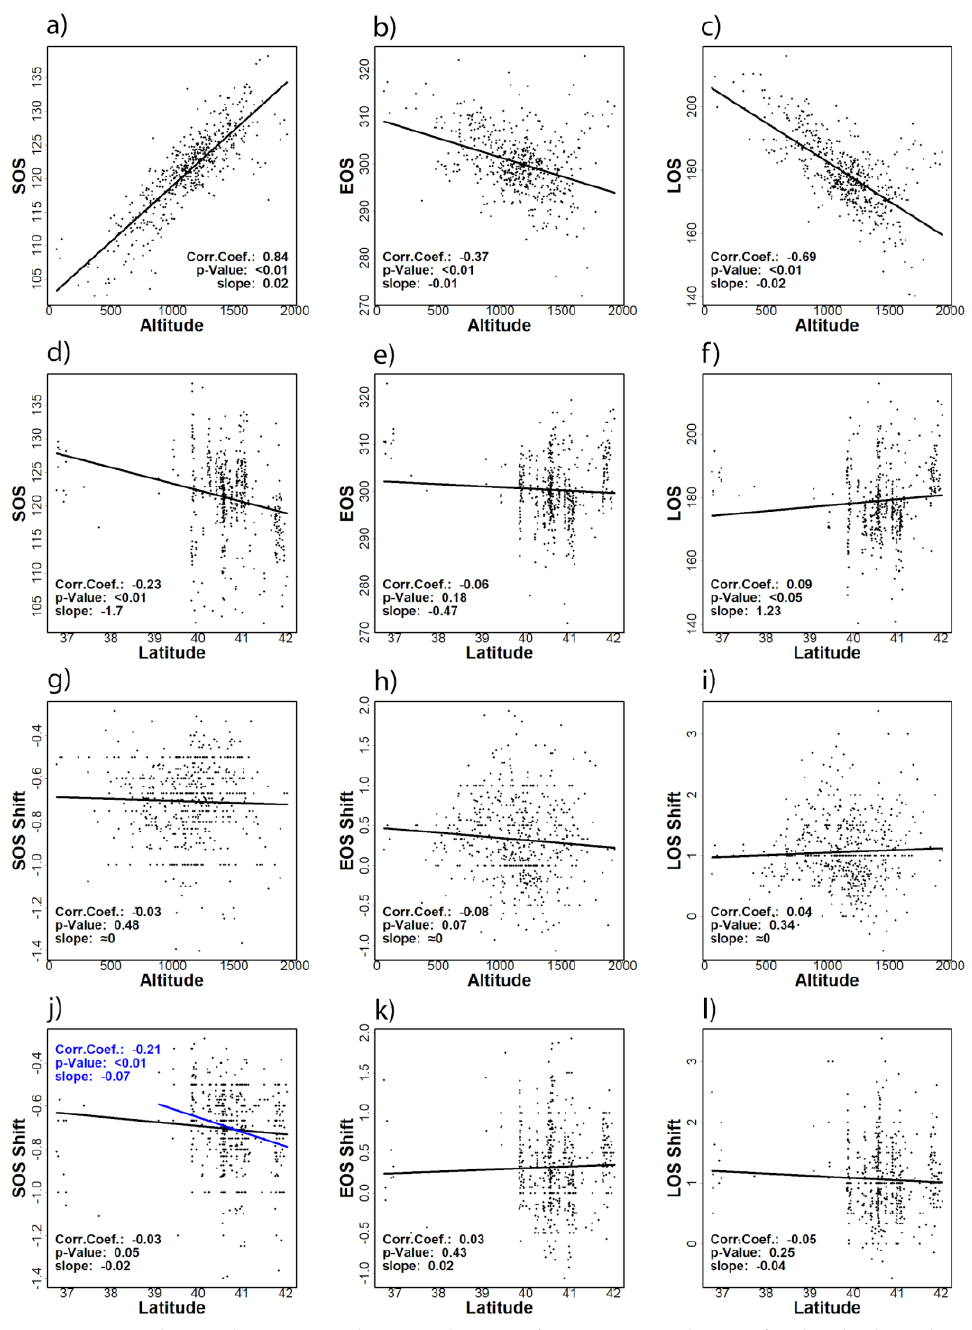
Figure 6. Correlations between multi-annual mean of SOS, EOS, and LOS of individual pixels and altitude ( a , b and c respectively) and latitude ( d , e and f respectively) and correlations between the shifts (Sen’s slope) in SOS, EOS and LOS of individual pixels and altitude ( g , h and i respectively) and latitude ( j , k and l respectively). Blue color in ( j ) remarks the correlation between SOS shift and latitude for the pixels between 39° N and 42° N while black color includes all pixels in study area.